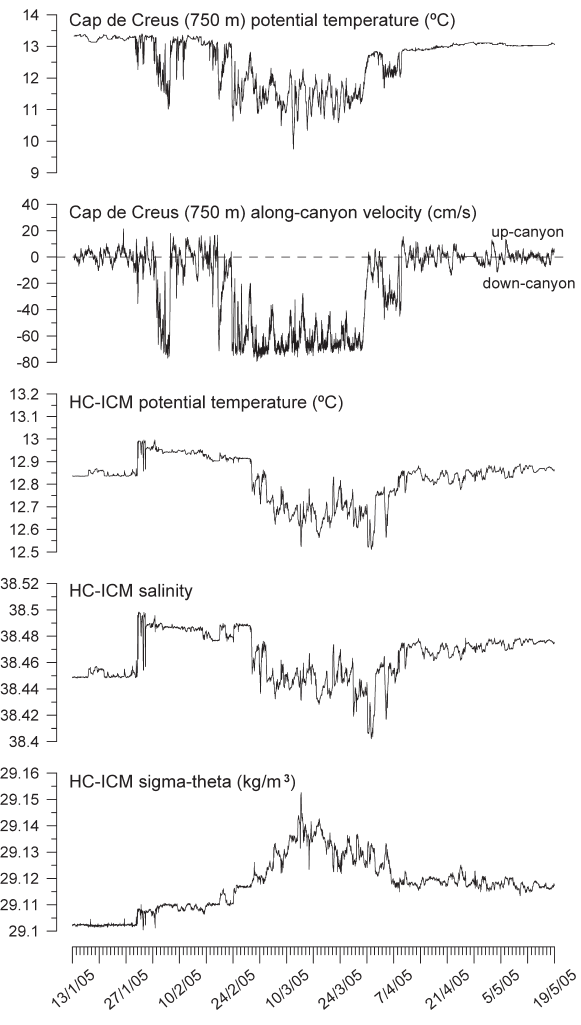
Fig. 4. – Time series of the potential temperature and along-canyon current component at 750 m along the Cap de Creus Canyon axis, together with the potential temperature, salinity and potential densi- ty records at the HC-ICM mooring, during the intense dense water formation events in winter